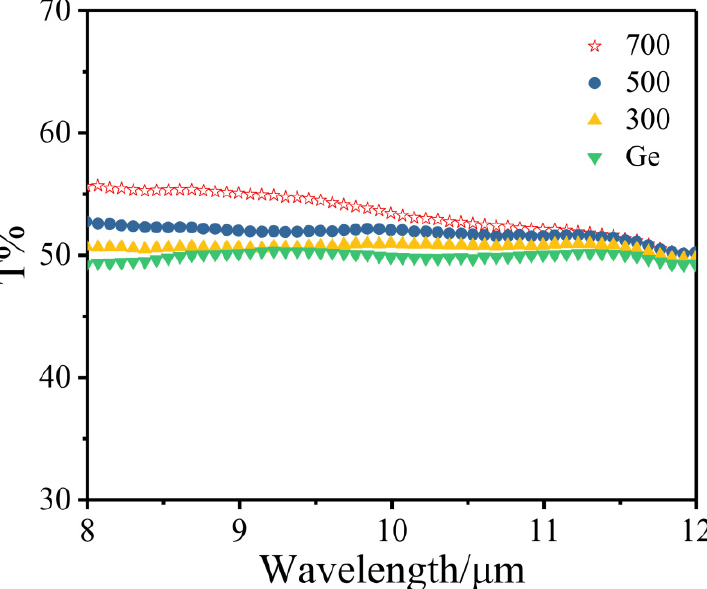
Figure 2. The transmittance of Monolayer LaF 3 infrared film with different thicknesses (8 – 12 μ m).